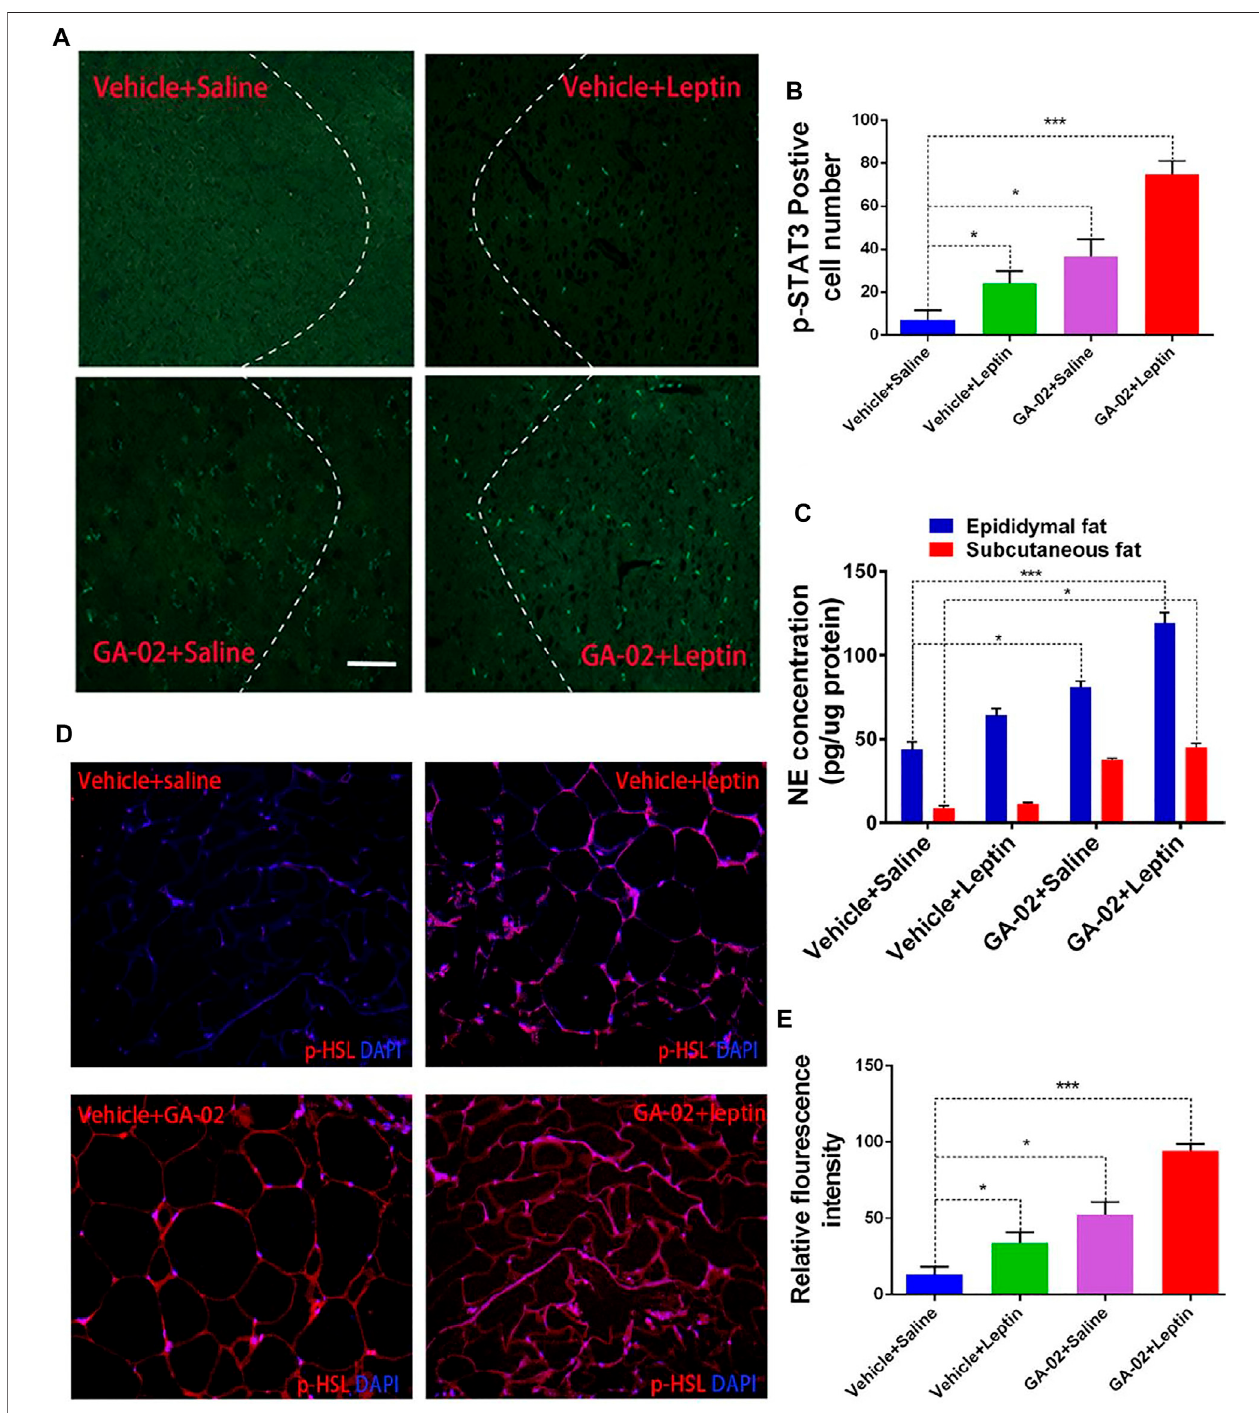
FIGURE 8 | Representative images of vWAT, BAT, sWAT and eWAT adipocytes. The adipocytes volume and diameter changes in DIO mice treated with vehicle and GA-02 (20 mg/kg; i.p.) for 14 days (mean ± SEM). Scale bar, 100 µm. (* p < 0.05, ** p < 0.01, *** p < 0.001).